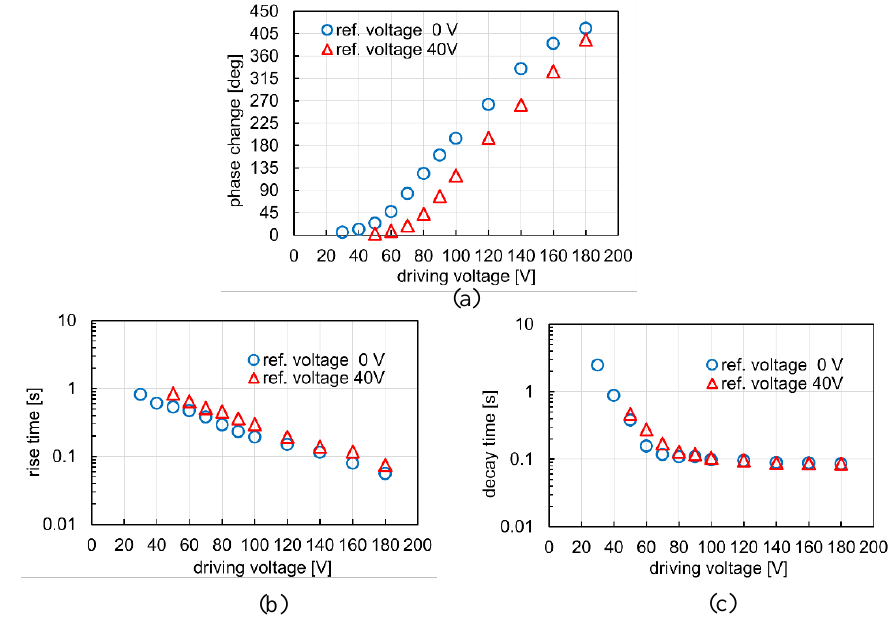
Figure 13. Driving voltage dependencies of ( a ) phase change, ( b ) rise time, and ( c ) decay time in NF/RDP-94990 complex with reference voltage 0 V and 40 V.